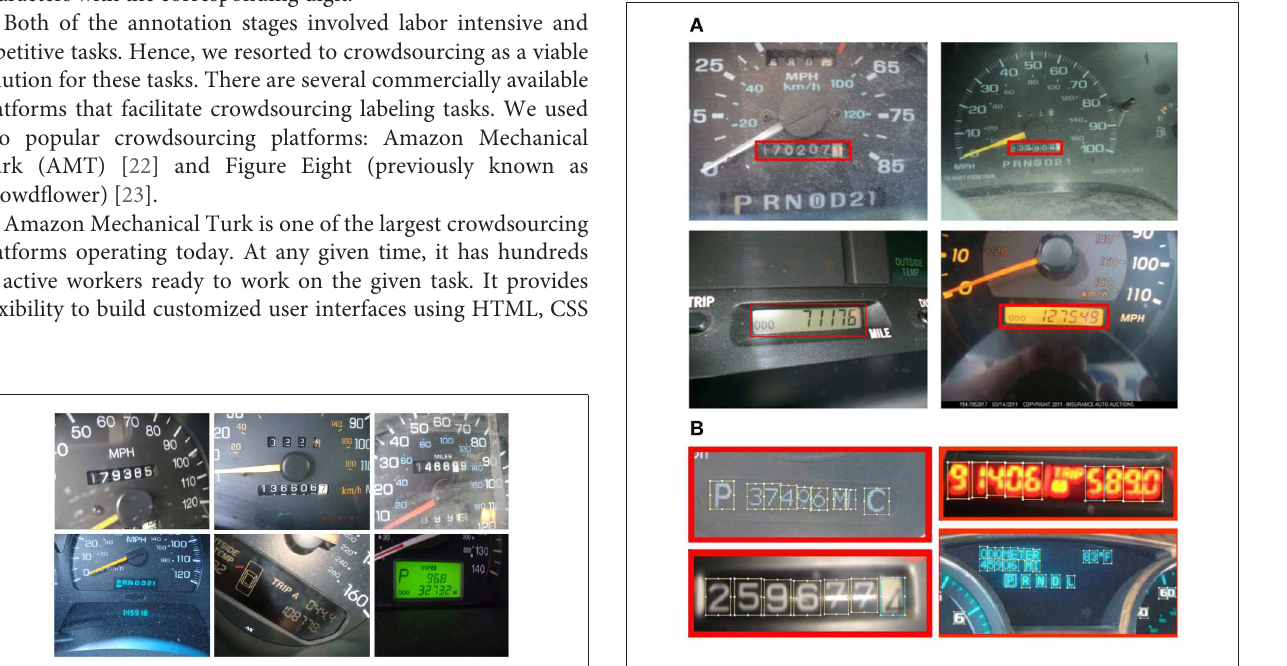
FIGURE 3 | Sample odometer images.